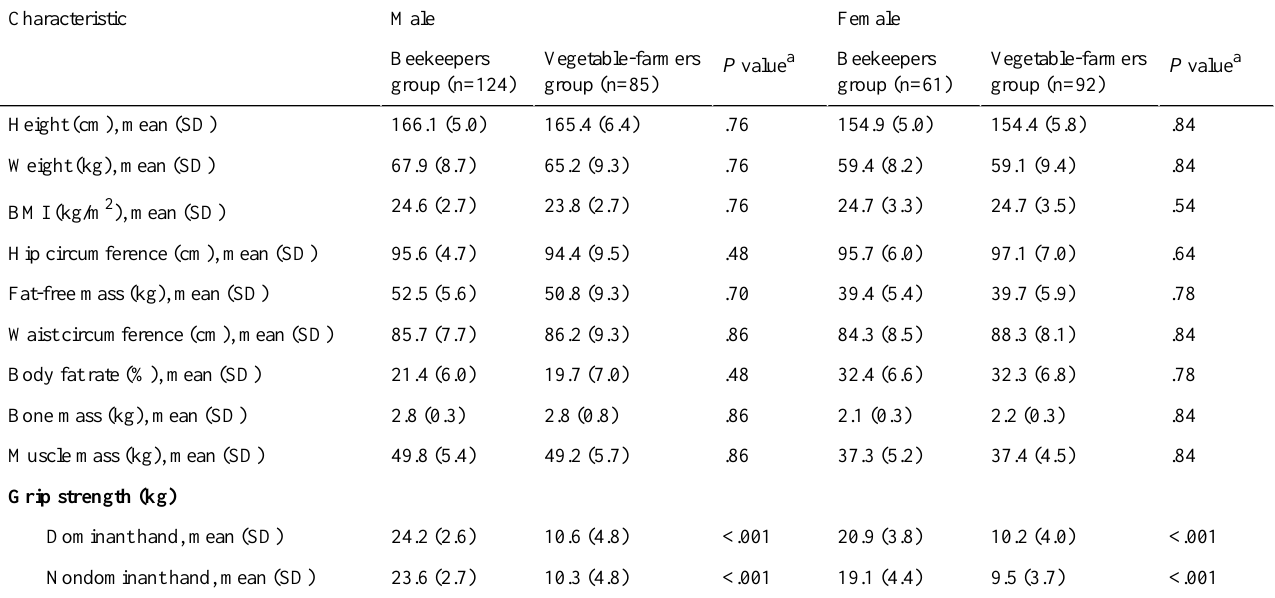
Table 2. Physical examination results of the beekeepers group and the vegetable-farmers group, sampled from Wuhan, China, between February and April